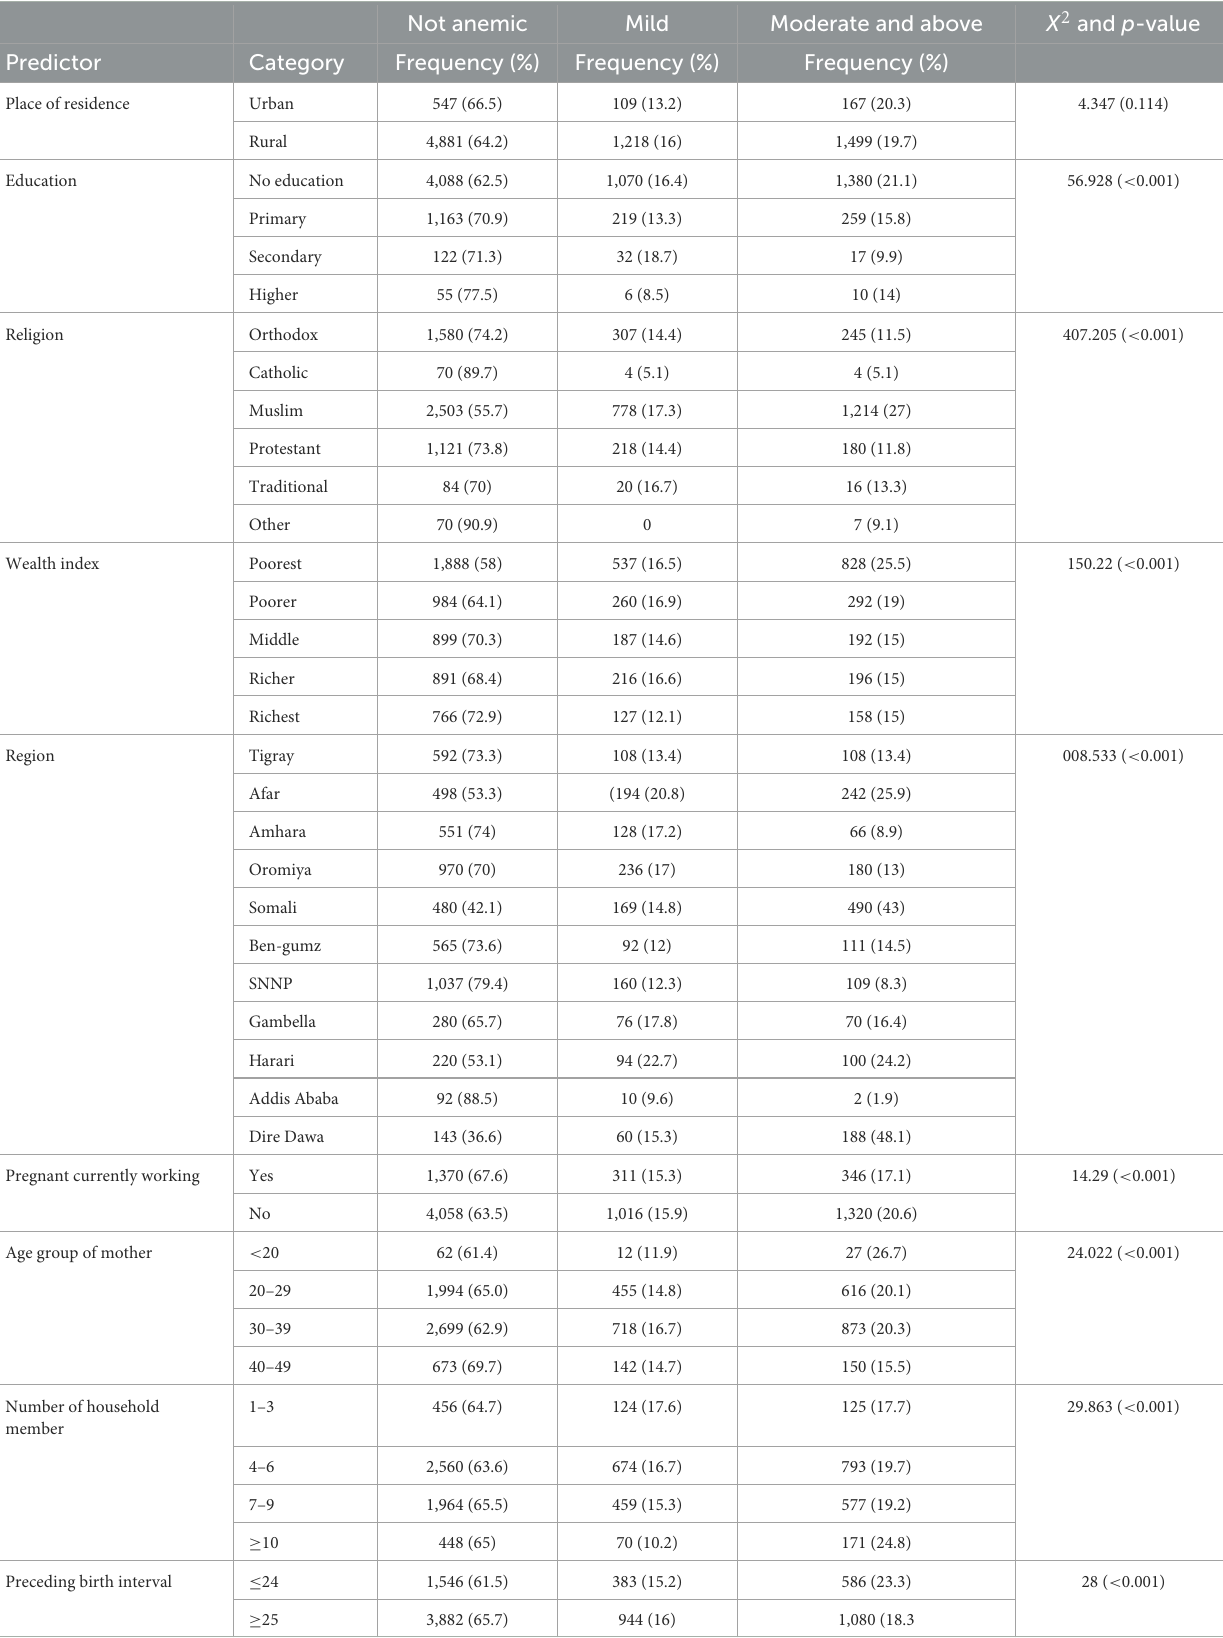
TABLE 3 The association of socio-demographic, socio-economic, and environmental variables with anemia level among pregnant women.